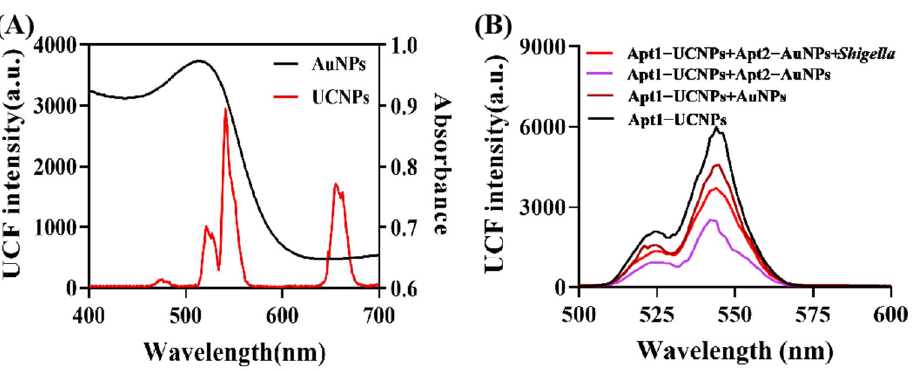
Figure 3. Fluorescence spectra of UCNPs and UV-Vis absorption spectra of GNPs ( A ); fluorescence spectra of apt2 − UCNPs with addition of GNPs, apt1 − GNPs, and apt1 − GNPs − Shigella ( B ) .